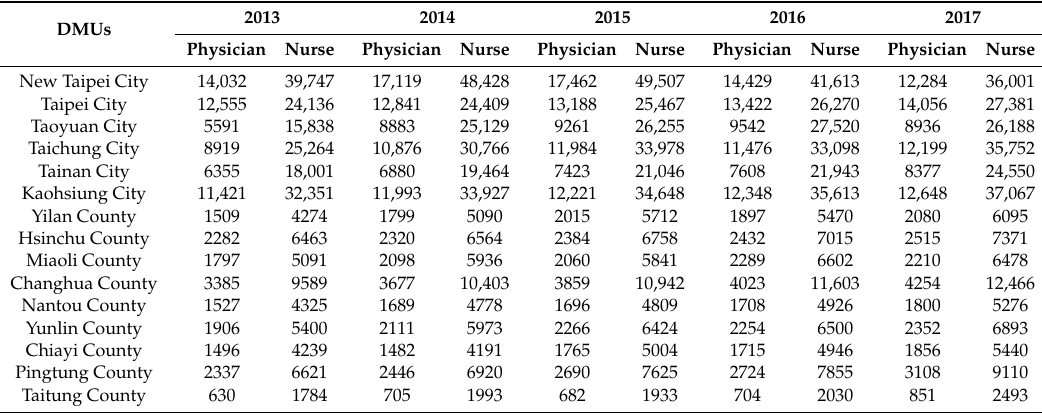
Table A1. Target quantity of medical sta ff for each administrative region in